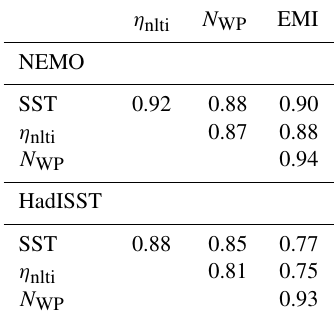
Table 2. Correlation between detrended time series of different in- dices for CP ENSO. The SST indices and η nlti are averaged over the Niño4 region. The upper table uses SST from the NEMO model simulation and the lower table uses SST from HadISST. All corre- lations are significantly different from 0 at the 99%